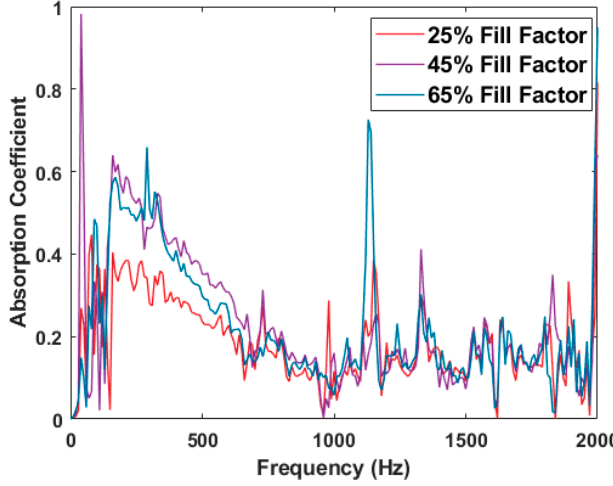
Figure 2. Plots of the absorption coefficients for the composite materials with different fill factors.